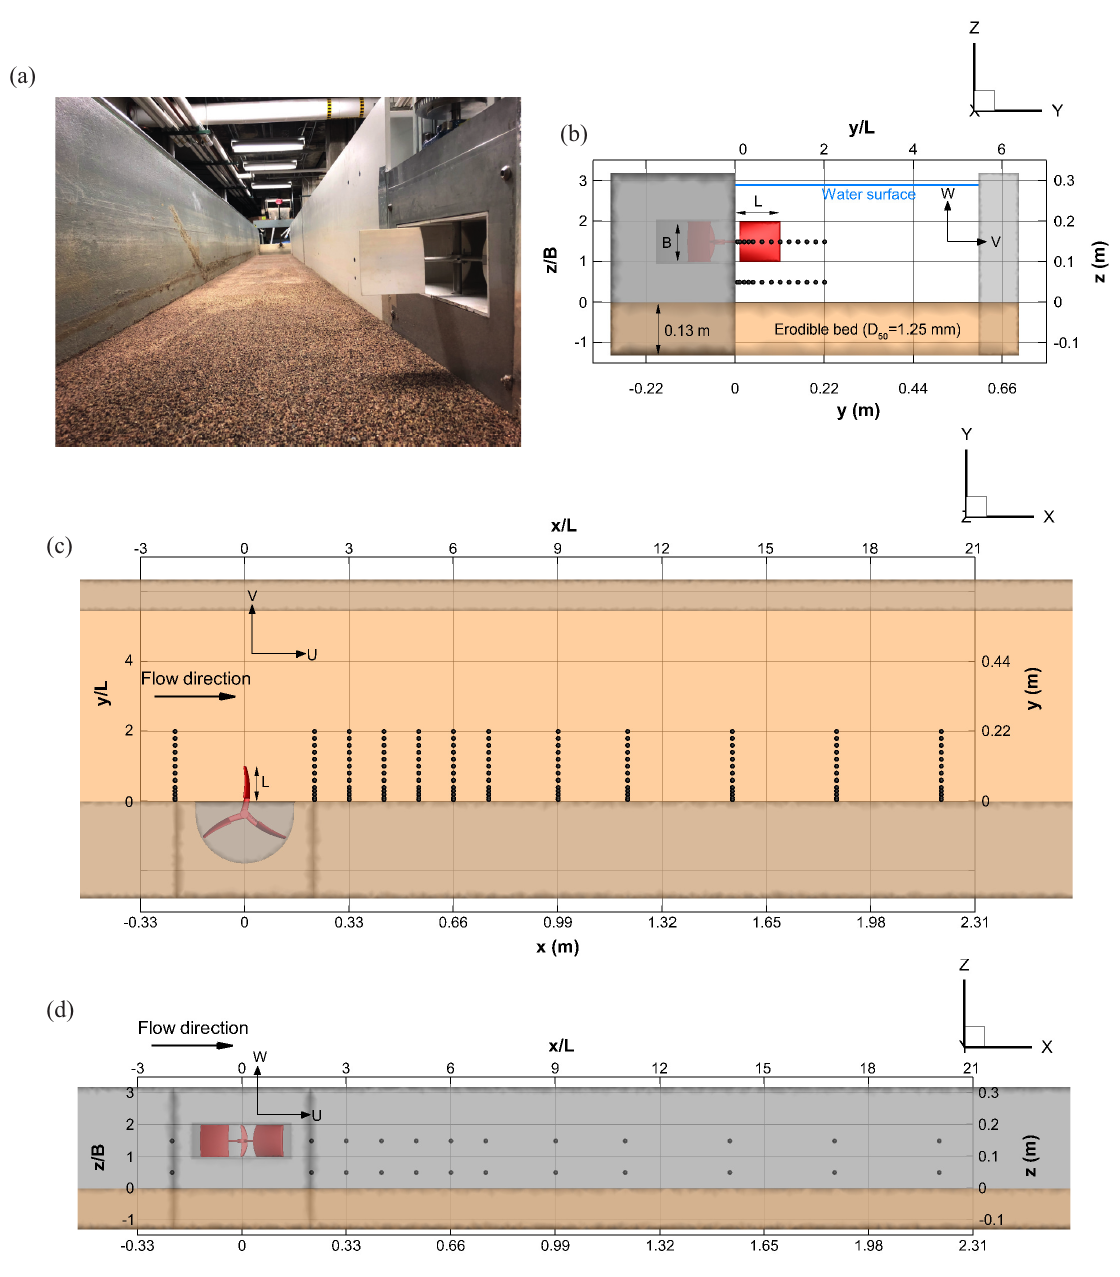
Figure 2. ( a ) The tested prototype turbine model, ( b ) view of the channel cross section, and ( c ) planar and ( d ) lateral side views of the test section with marked measurement locations; x, y, and z are the streamwise, transverse, and vertical coordinates, respectively, corresponding to the velocity components U , V , and W